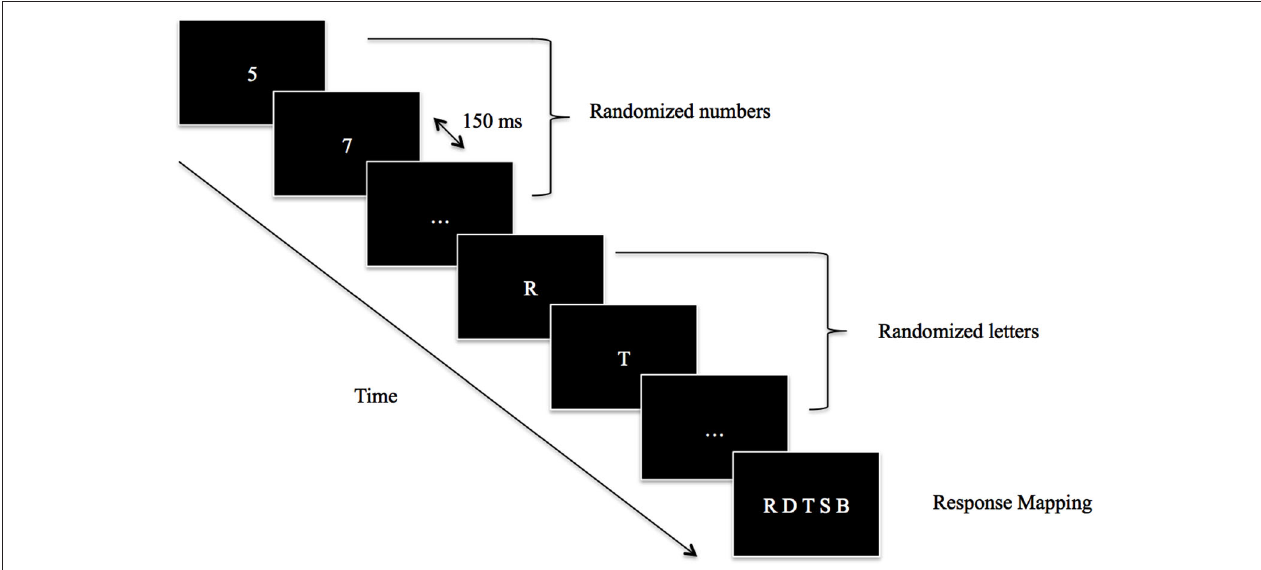
(Voluntary Action, Involuntary Action, Tone 1, Tone 2) a response mapping appeared and participants chose the letter that was on the screen at the occurrence of the event of interest (e.g., Voluntary Action, Involuntary Action, Tone 1, Tone